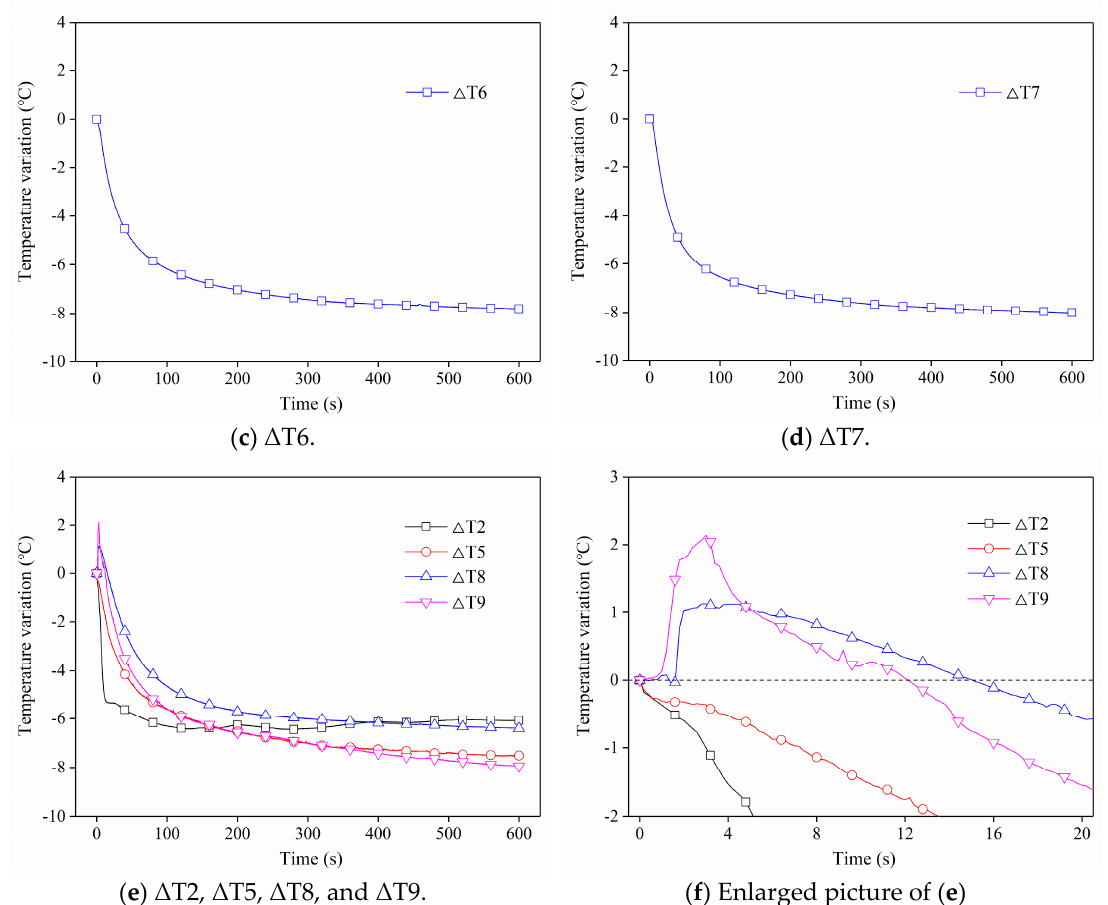
Figure 7. Temperature variation curves after the outburst trigger.